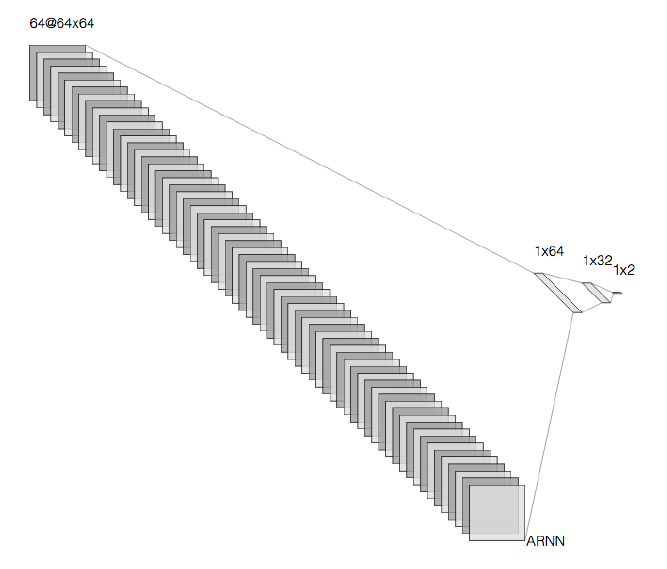
Figure 9. The neural network